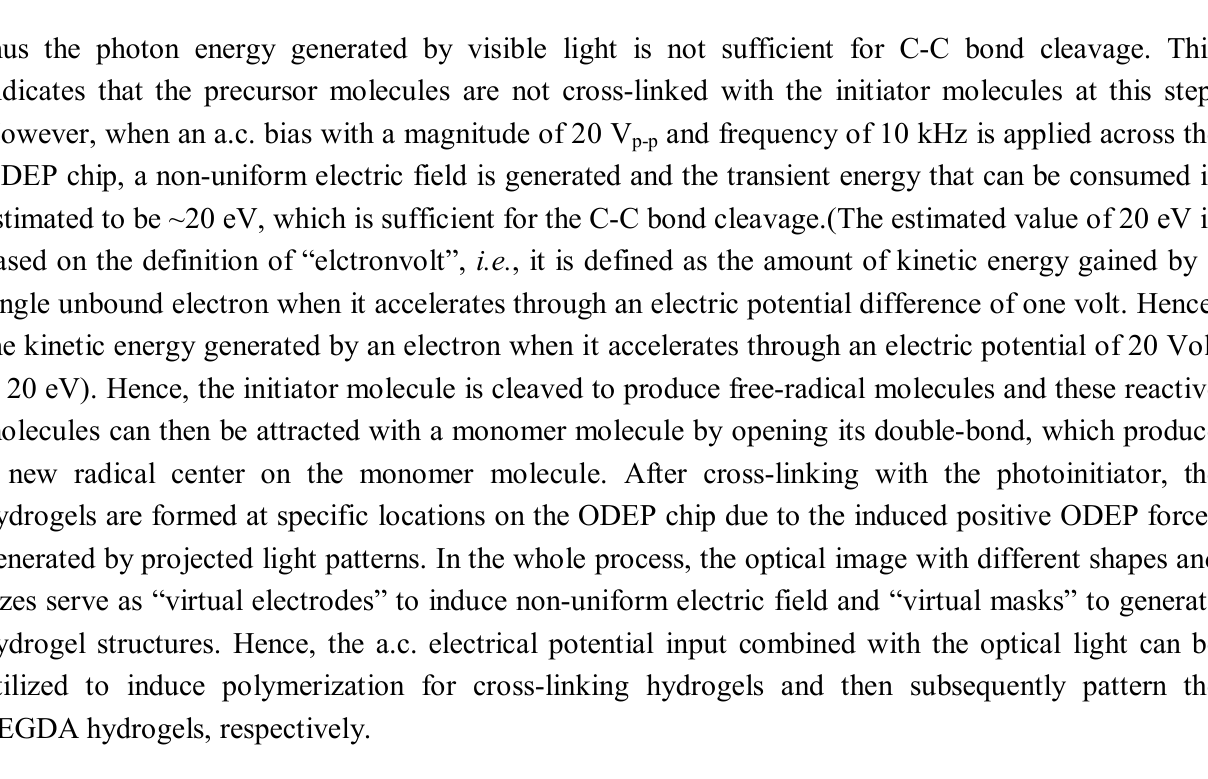
Figure 2. The process of PEGDA chain reaction with a